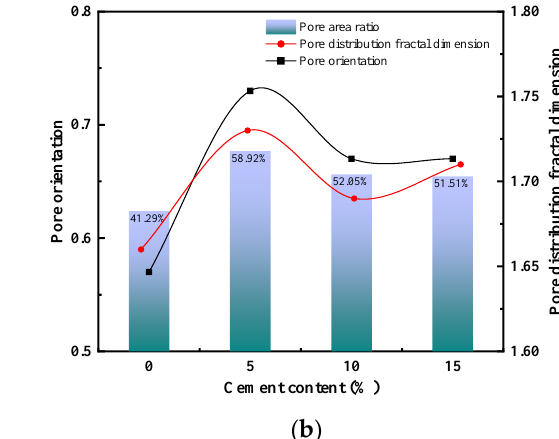
Figure 12. Binarized image of microstructure of permeation grouting silty clay. ( a ) Cement content of 0%. ( b ) Cement content of 5%. ( c ) Cement content of 10%. ( d ) Cement content of 15%.